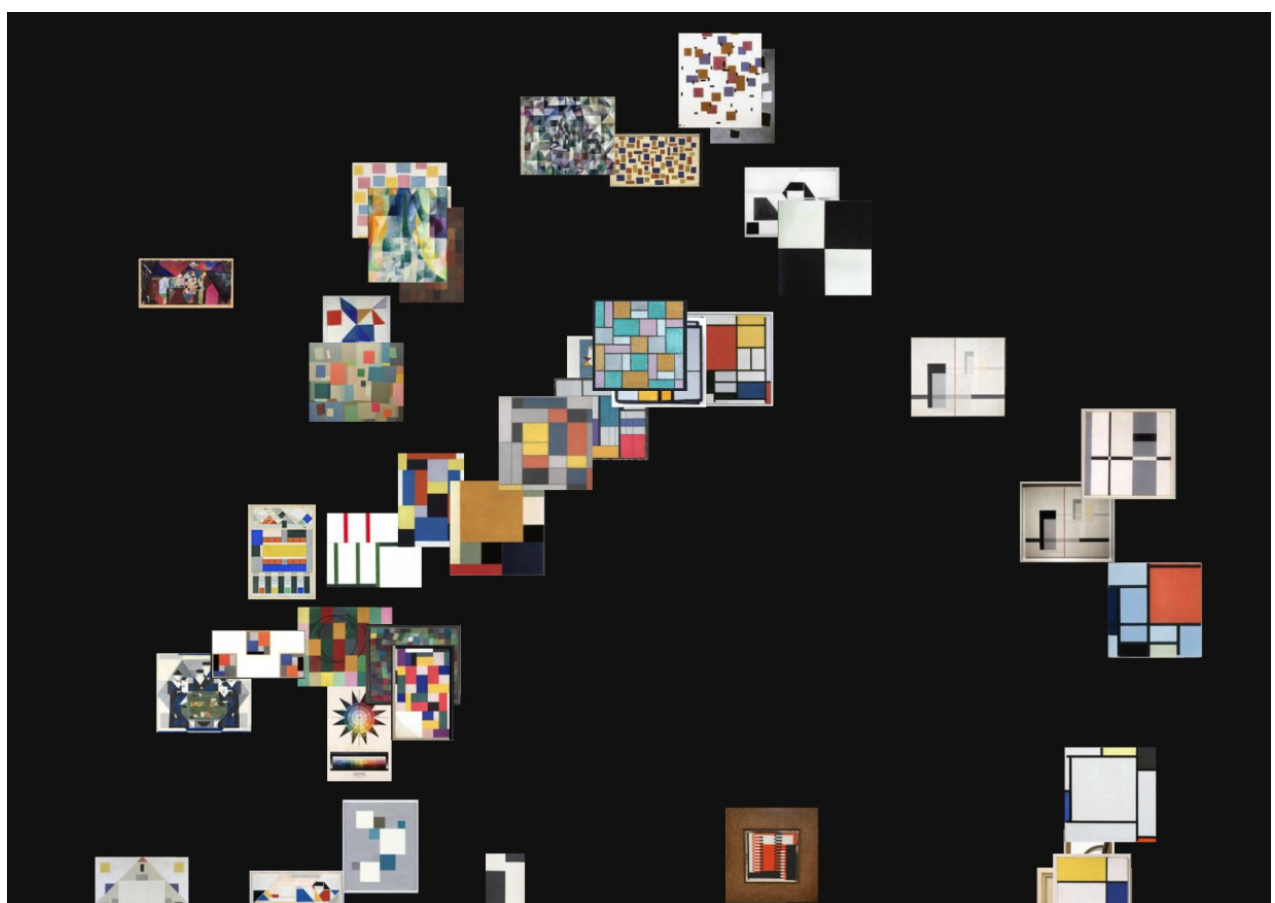
Figure 7. Section of a two-dimensional projection of an image vector space. Barr X Inception CNN Project. Available on: https://digital-narratives.versae.es/# (accessed on 28 July 2022) (screenshot).